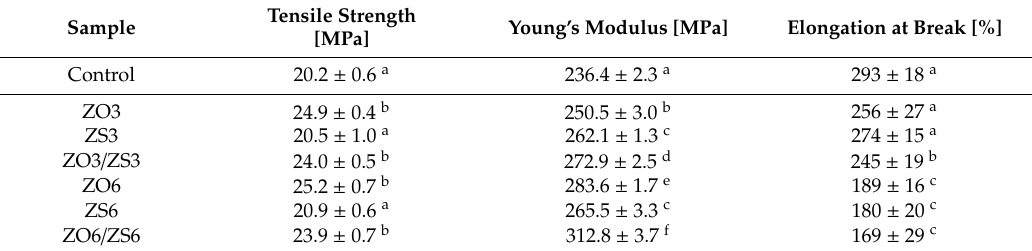
Table 4. Comparison the mechanical properties of PE films containing containing a masterbatch with zinc oxide (ZO) and / or zinc stearate (ZS) ( n = 10, p <